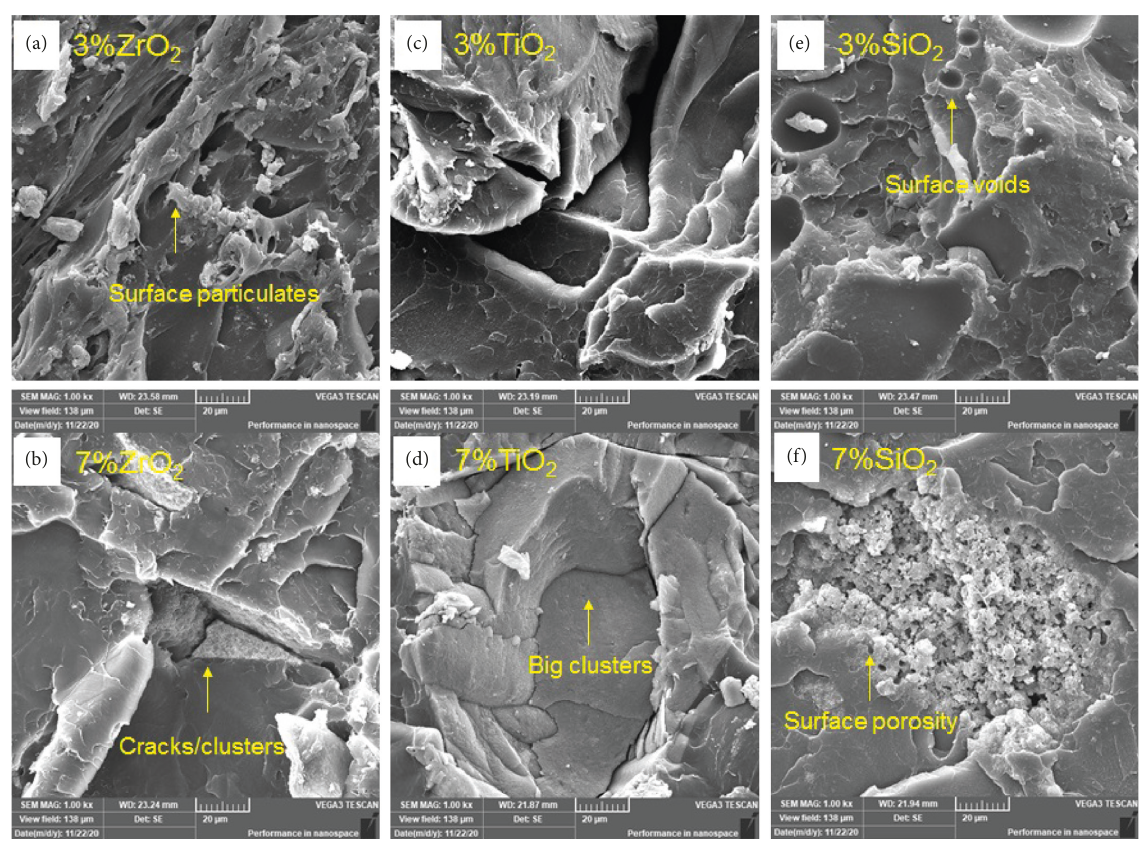
Figure 3: (a–f) Representative SEM images for nanoparticles-modified specimens: (a) Z3, (b) Z7, (c) T3, (d) T7, (e) S3, and (f)